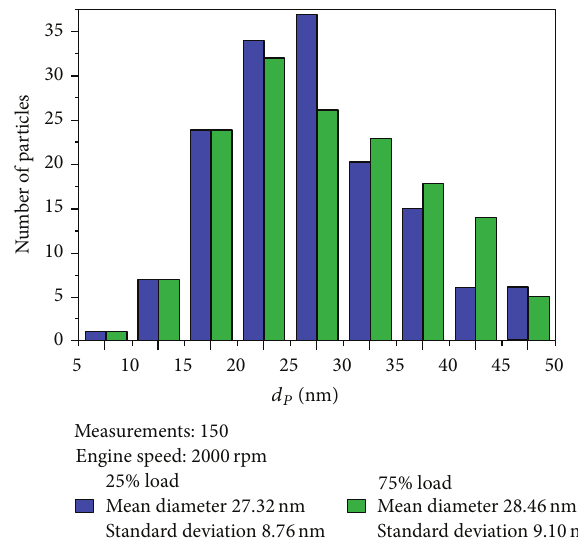
Figure 2: Primary particle diameter distribution when fueled with pure diesel.